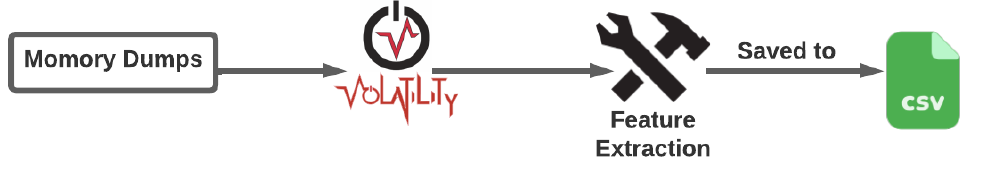
Figure 9. Feature extraction process from memory dump using